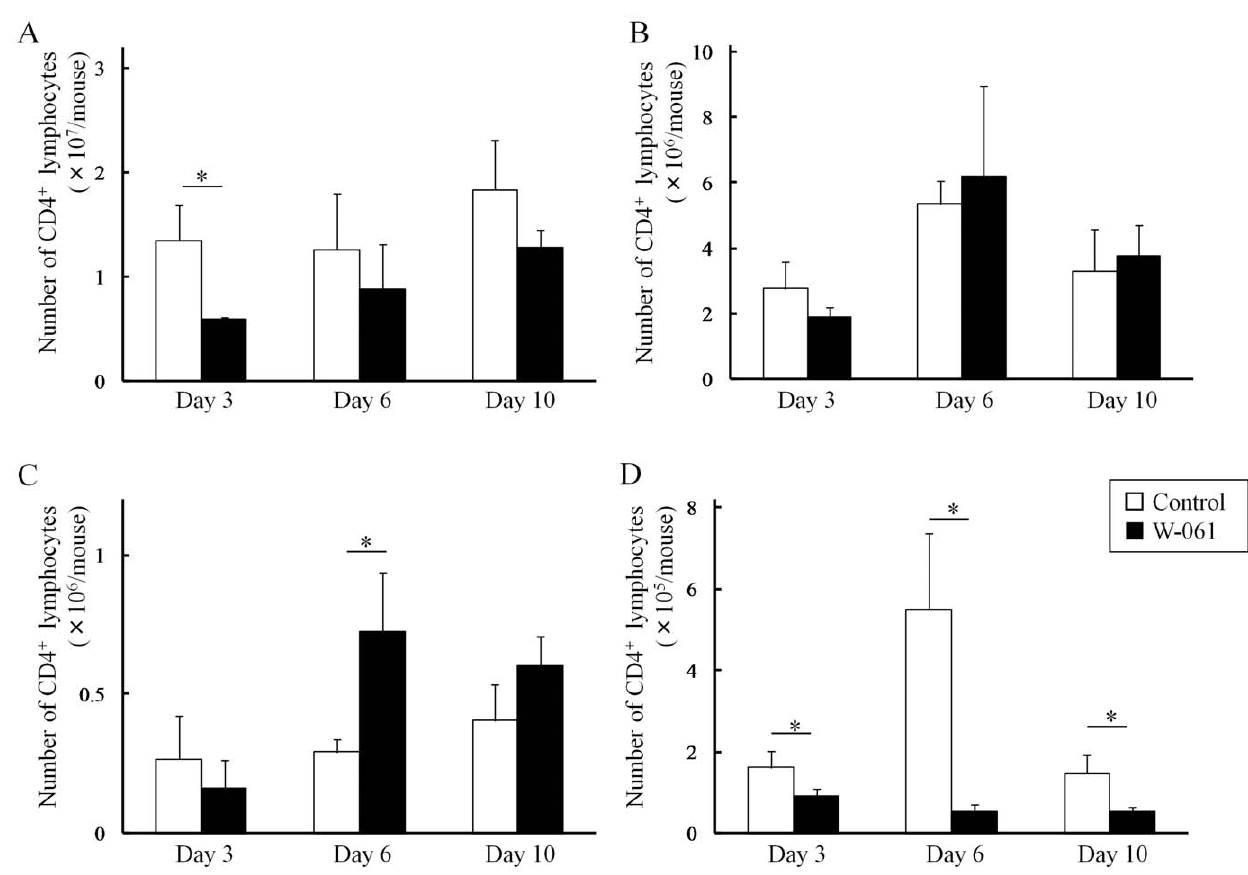
Figure 2. Change of the numbers of CD4 + T cells in (A) SP, (B) MLN, (C) PP and (D) LP. Data represent absolute values (means 6 SD, n=4 per group on days 3 and 6, n=6 per group on day 10, * p , 0.05).